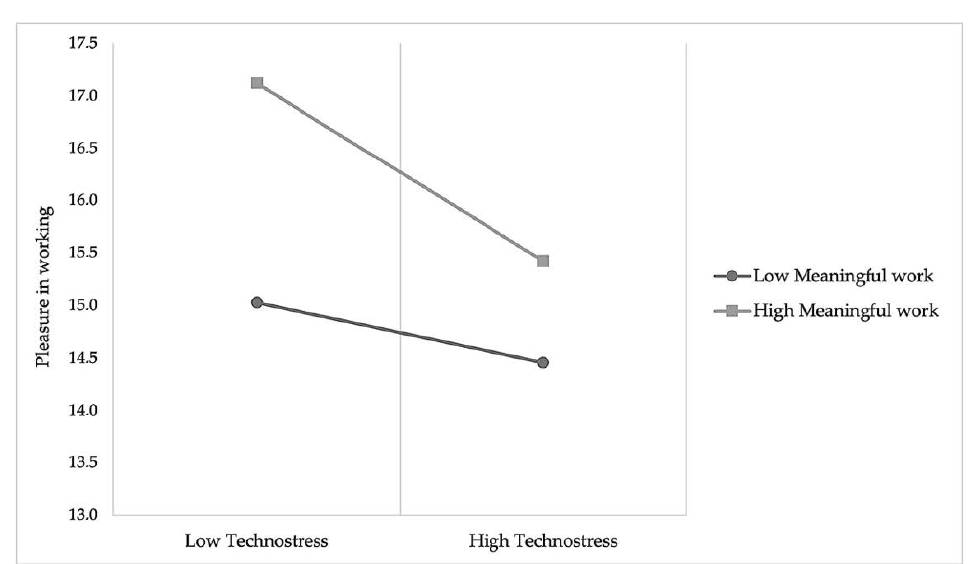
Figure 2. Conditional effects of technostress on pleasure in working at different values of the moderator (N = 219).